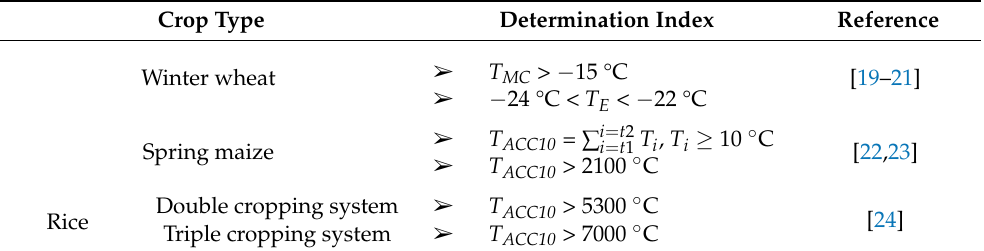
Table 1. Determination indices of potential northern planting boundary of three main grain crops in China. Crop Type Determination Index Reference Winter